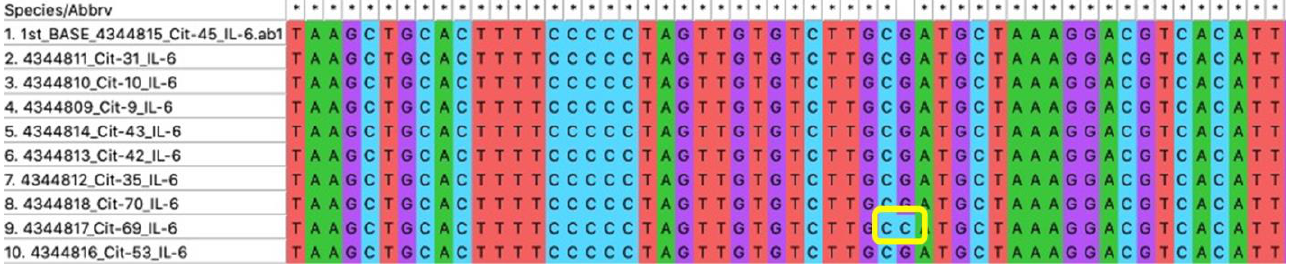
Figure 5. Multiple alignments of IL-6 gene to detect G174C polymorphism by direct sequencing. Table 2. Distribution of IL-6 genotypes in this study.